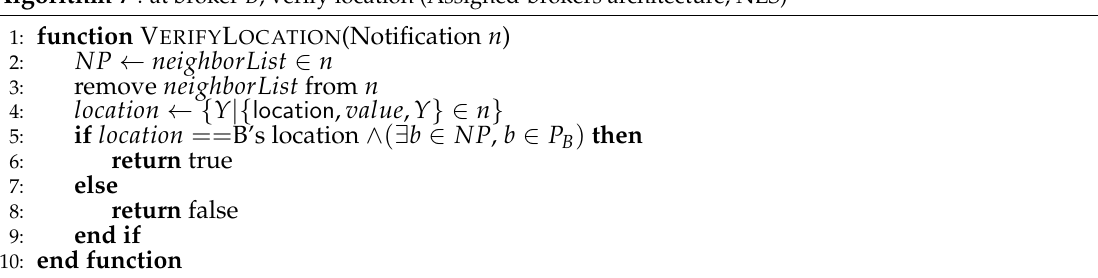
Algorithm 7 : at broker B , verify location (Assigned-brokers architecture, NLS)